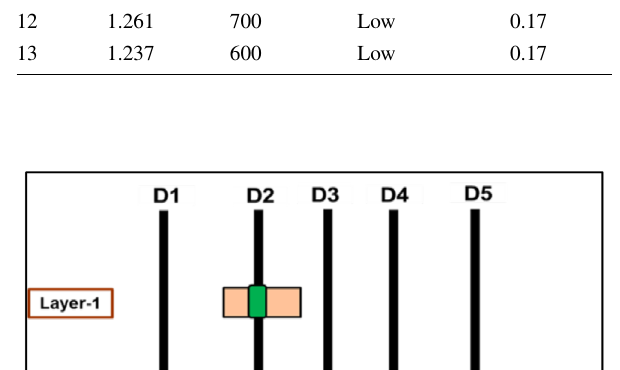
Fig. 16 Well 2 production history match (case 2)